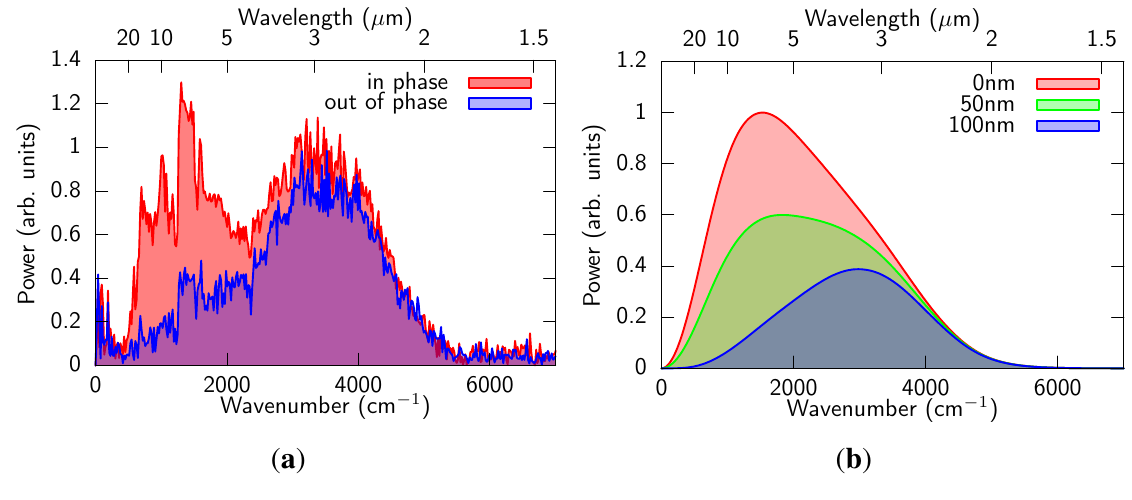
Figure 3. ( a ) Typical spectra of the MIR pulse generated through filamentation in nitrogen. Some sharp structure around 1000 cm − 1 is due to absorption of Si wafer; ( b) The FWM spectra calculated with the measured fundamental and the SH spectra after the filament (shown in Figure 2). The optical path difference between the fundamental and SH are 0 nm (red), 50 nm (green), and 100 nm (blue), respectively.